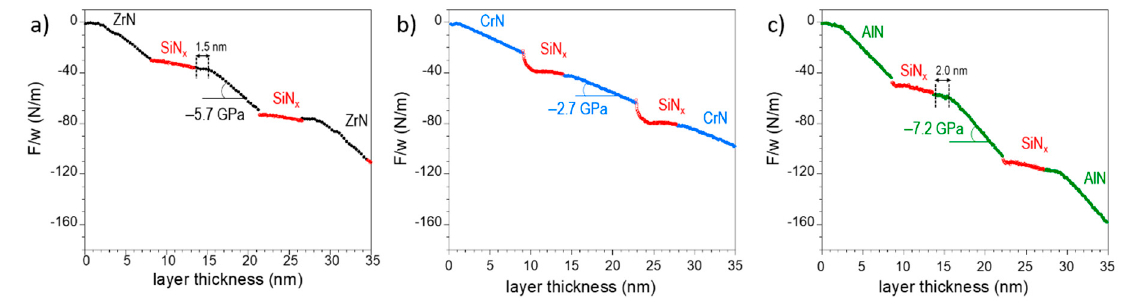
Figure 3. In situ stress evolution during growth of multilayered films: ZrN / SiN x ( a ); CrN / SiN x ( b ); and AlN / SiN x ( c ). The data were obtained from MOSS and are displayed as the variation of the force per unit width (F / w) vs. layer thickness. The slope of the curves gives the information on the incremental stress, ranging from − 7.2 GPa (AlN) to − 2.7 GPa (CrN).